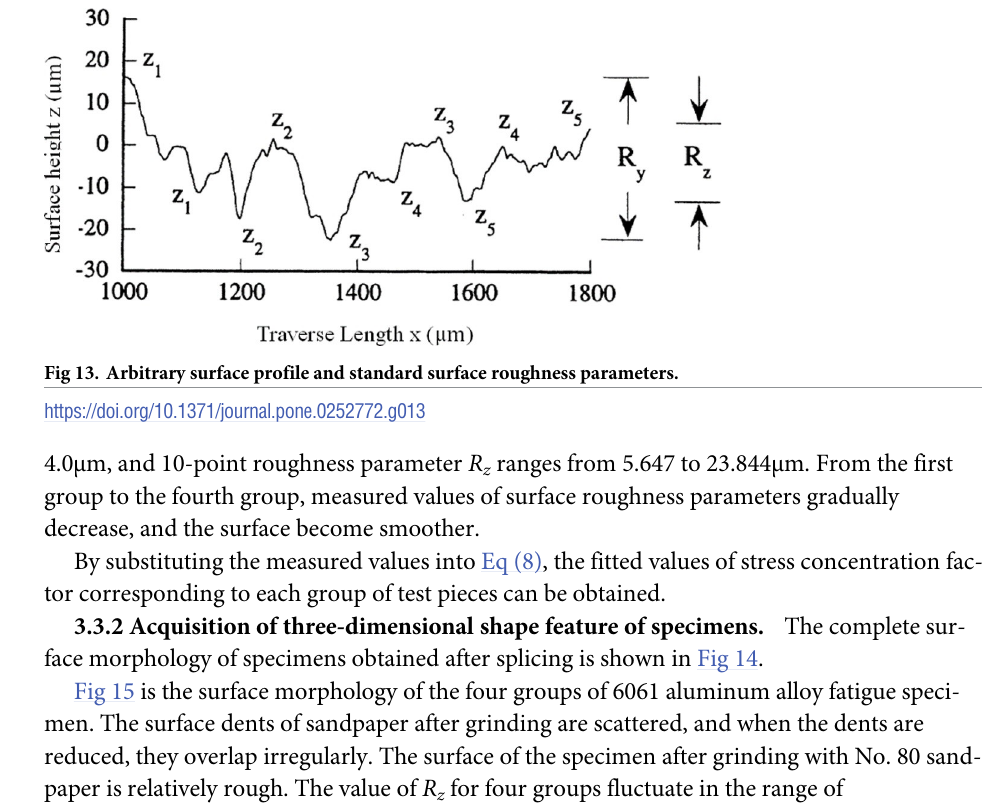
4.0 μ m, and 10-point roughness parameter R ranges from 5.647 to 23.844 μ m. From the first z group to the fourth group, measured values of surface roughness parameters gradually decrease, and the surface become smoother.